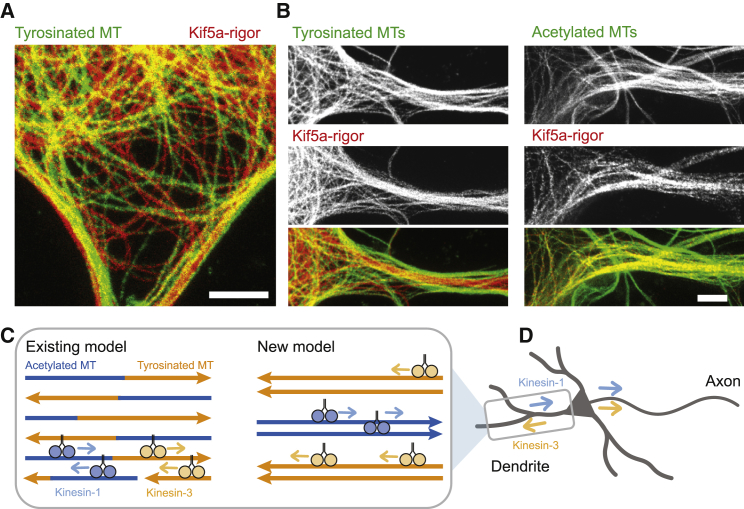
Kinesin-1 Prefers Stable, Acetylated Microtubules in Neuronal Axon and Dendrites(A and B) STED image of DIV4 polarized neuronal soma (A) or neurites (B) after 1 day expression of GFP-kif5a rigor stained for GFP and acetylated-tubulin or GFP and tyrosinated-tubulin. See also Figure S6.(C) Cartoon illustrating the existing and new model for dendritic microtubule organization. Arrowheads on microtubules depict plus ends. Kinesin-1 and Kinesin-3 preferentially move over stable/acetylated and dynamic/tyrosinated microtubules, respectively.(D) The new model can explain the selective entry of Kinesin-1 into axons. Arrows depict bias in transport directionality (see also Figure S7).Scale bars, 2 μm (A and B).